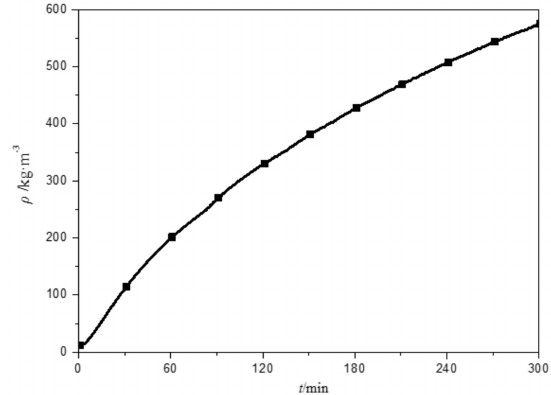
Figure 4. Variation of average density of the frost layer over time.